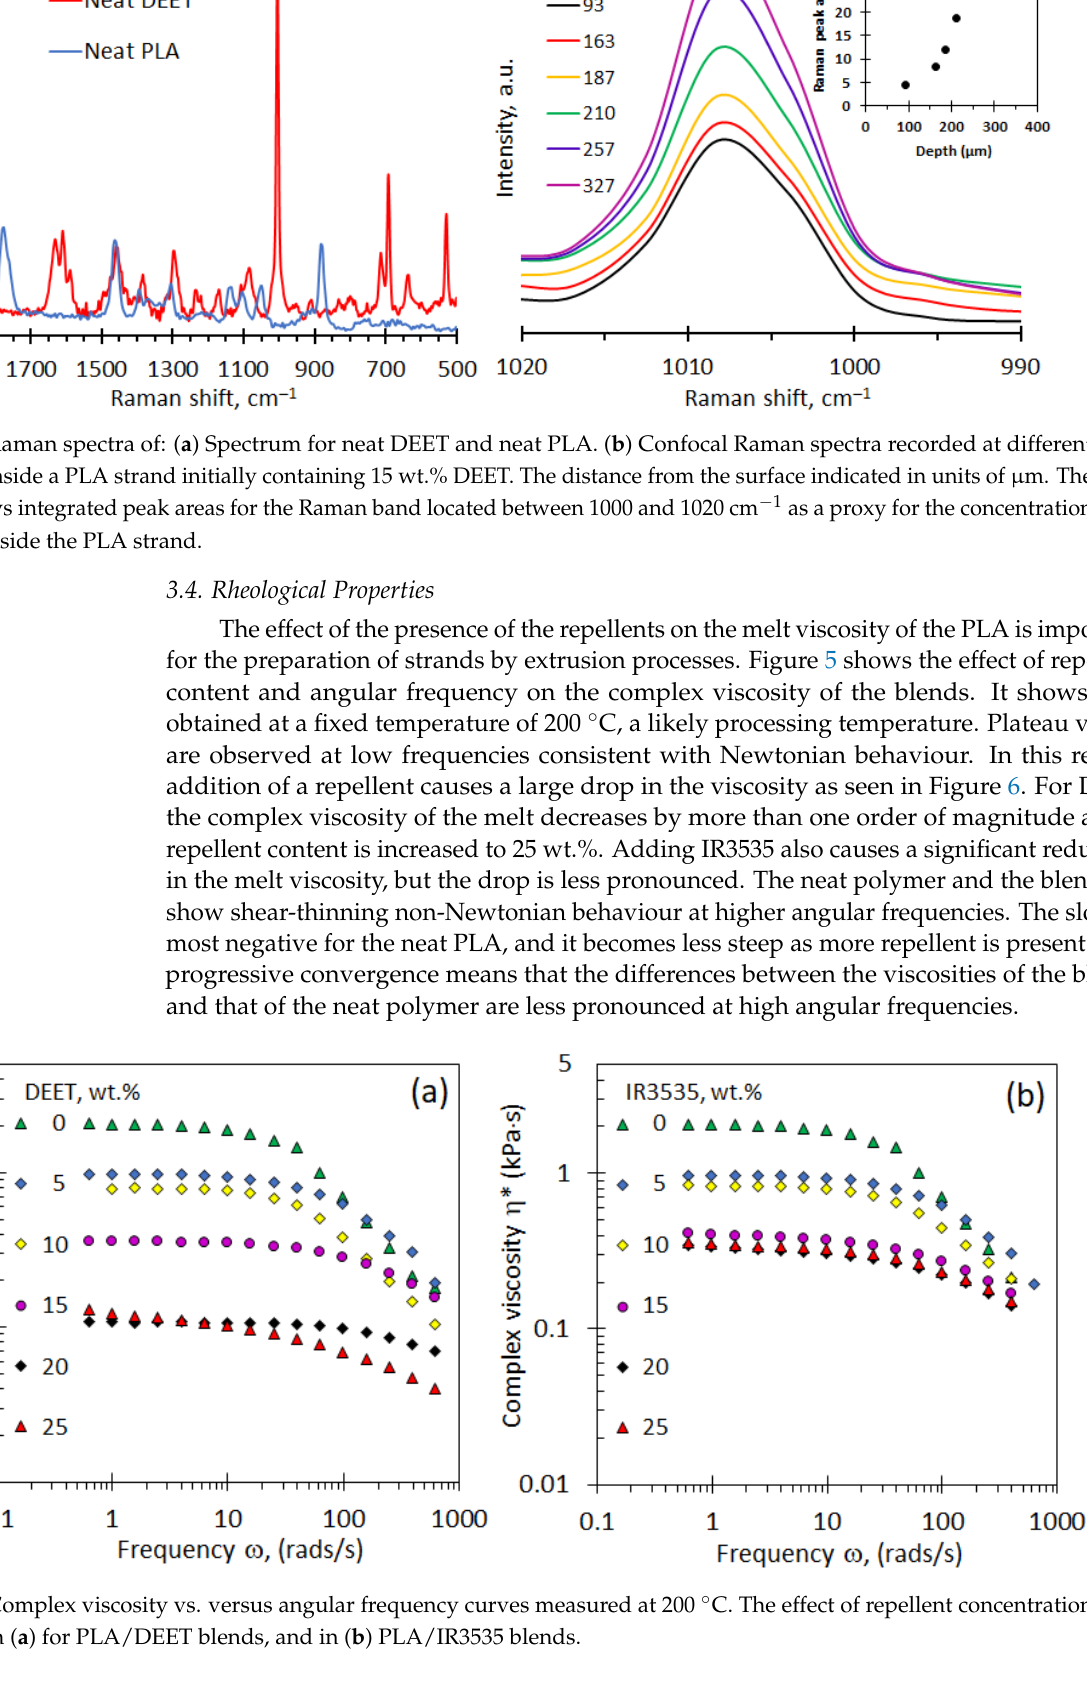
Figure 6. Variation of the complex viscosity with the concentration of the repellents DEET and IR3535. The plotted plateau values reflect measurements obtained at 200 ° C. 3.5. Repellents Release from PLA Strands The average in initial and final diameters of the strands after five months of ageing in a convection oven at 50 ° C are reported in Table 2. The data indicates that the loss of the repellents was associated with significant shrinkage. Therefore, the assumption of a constant strand diameter is not valid.